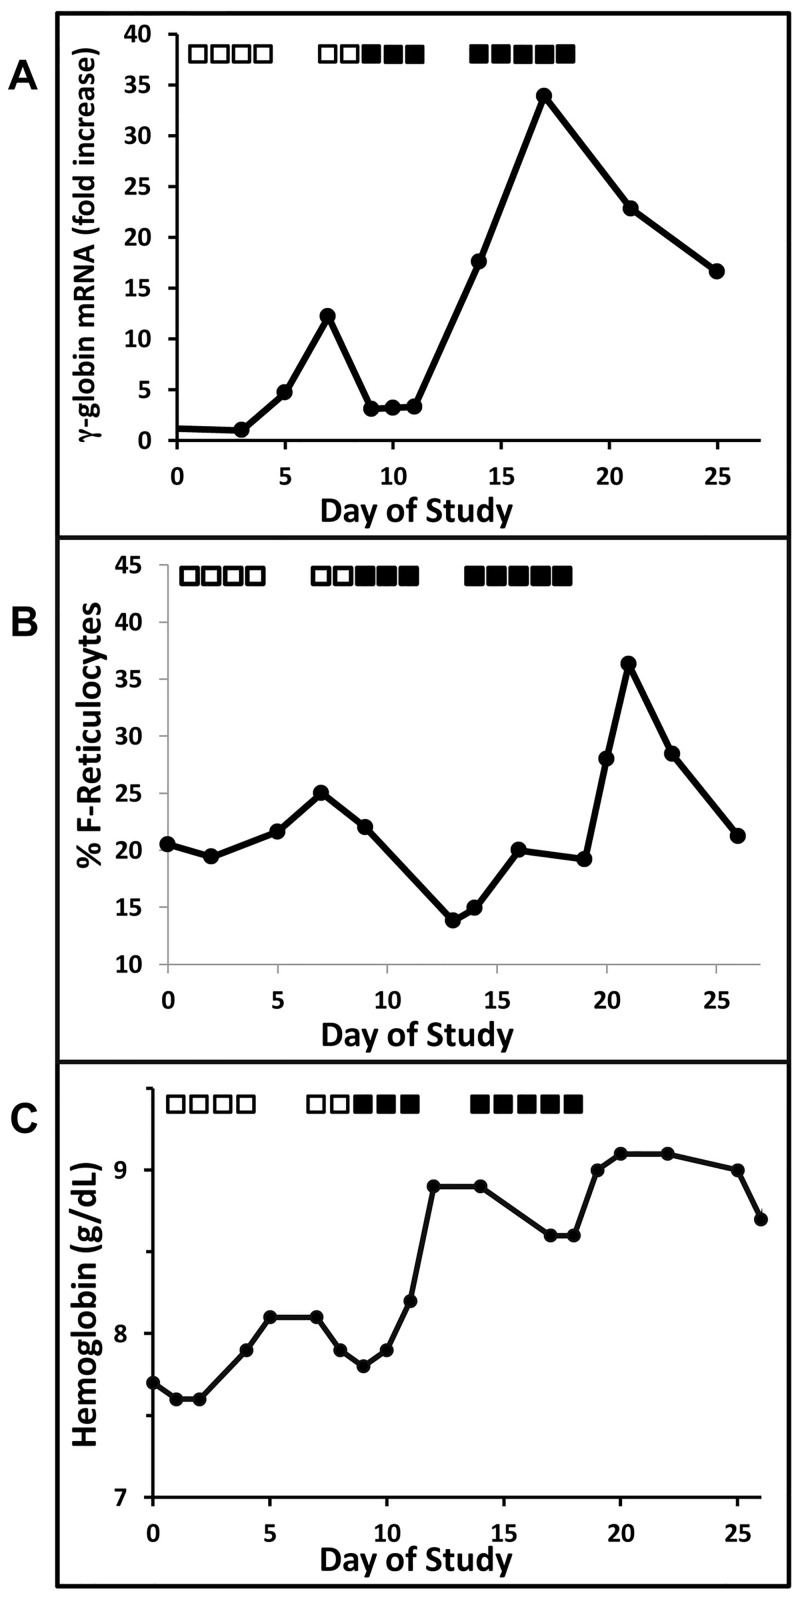
Fetal globin induction in an anemic baboon treated with Benserazide.(A.) Treatment with Benserazide resulted in a dose-dependent increase in γ-globin mRNA up to 34-fold. Two doses were tested, 1 mg/kg/dose (shown by the open squares) and 2 mg/kg/dose, (shown by the dark squares). (B.) F-reticulocytes increased by 15% during treatment with 2 mg/kg, and (C.) total hemoglobin increased by 1.5 gm/dl, despite the phlebotomy which exchanged the blood volume every 12 days.